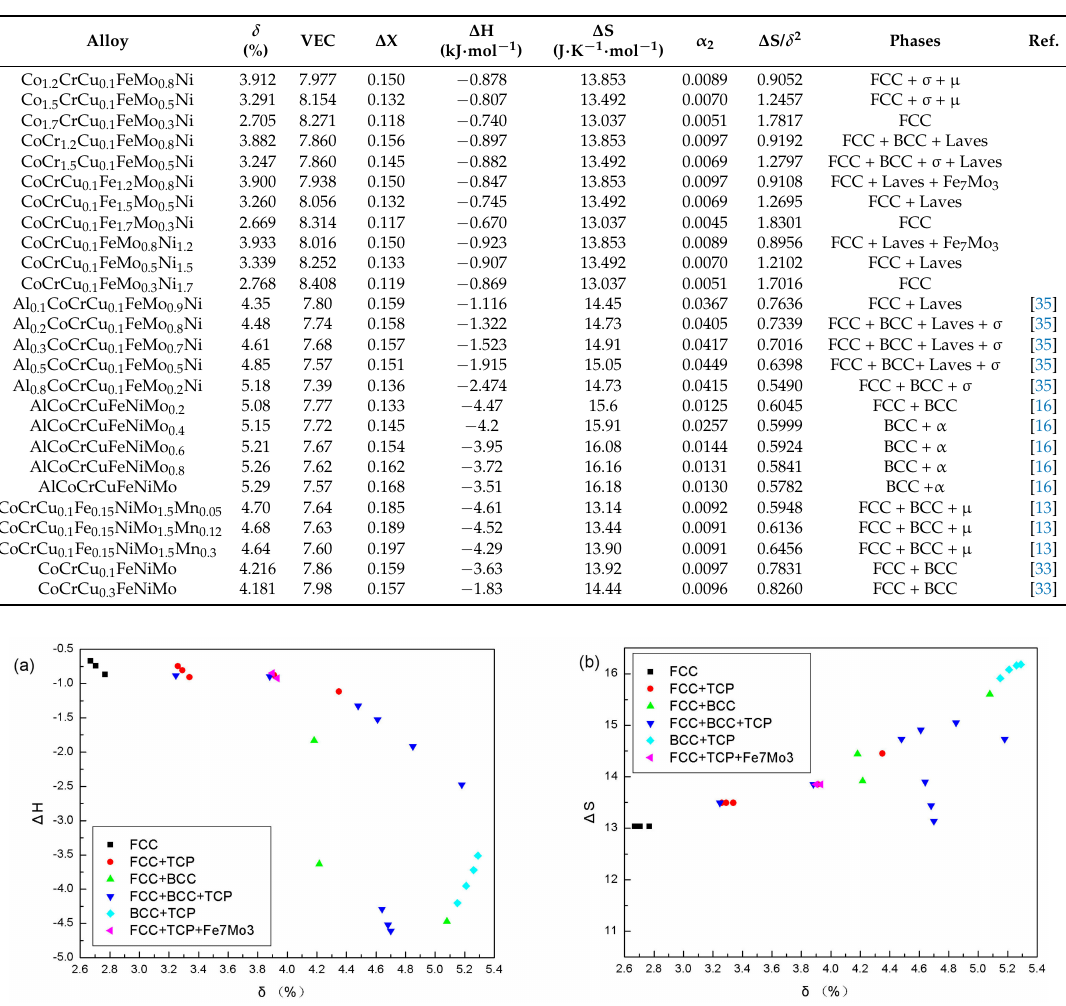
Table 3. Phases and parameters of CoCrCu 0.1 FeMoNi-based